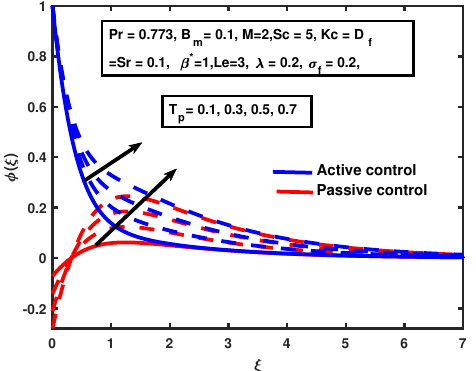
Figure 19. The impact of φ ( ξ ) on thermophoresis T p .